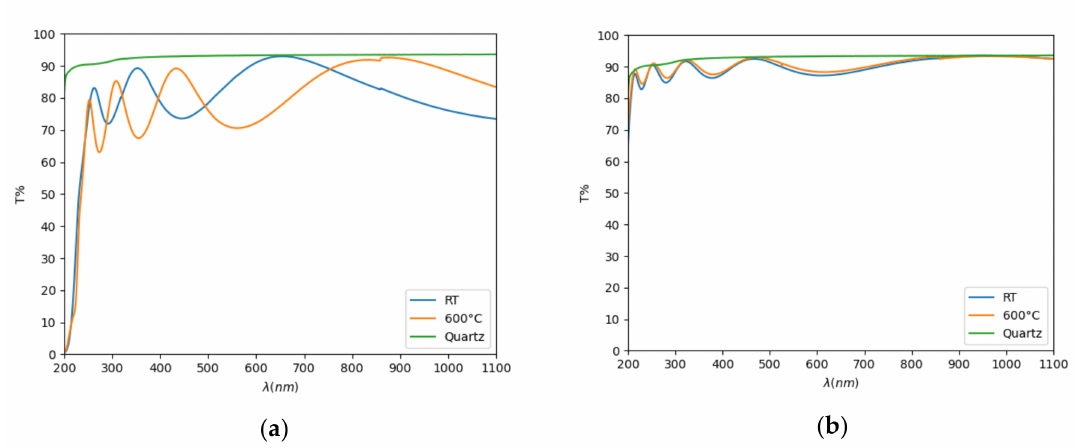
Figure 6. Transmission spectra of ( a ) hafnium silicate and ( b ) aluminium